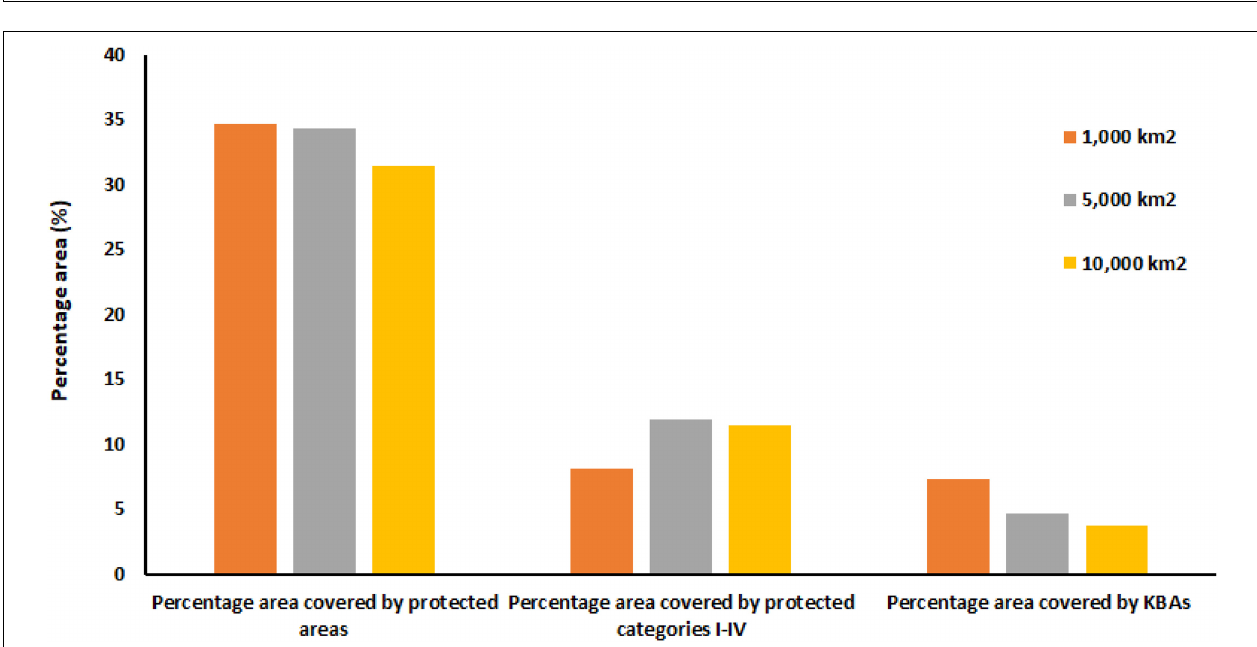
FIGURE 5 | The percentage of ecologically intact sites (polygons) covered by protected areas of all types (left), protected areas in IUCN categories I-IV (center), and covered by KBAs